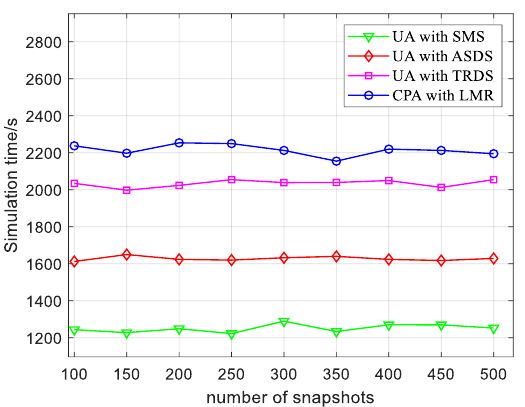
Figure 7. Simulation time versus number of snapshots for different algorithms.